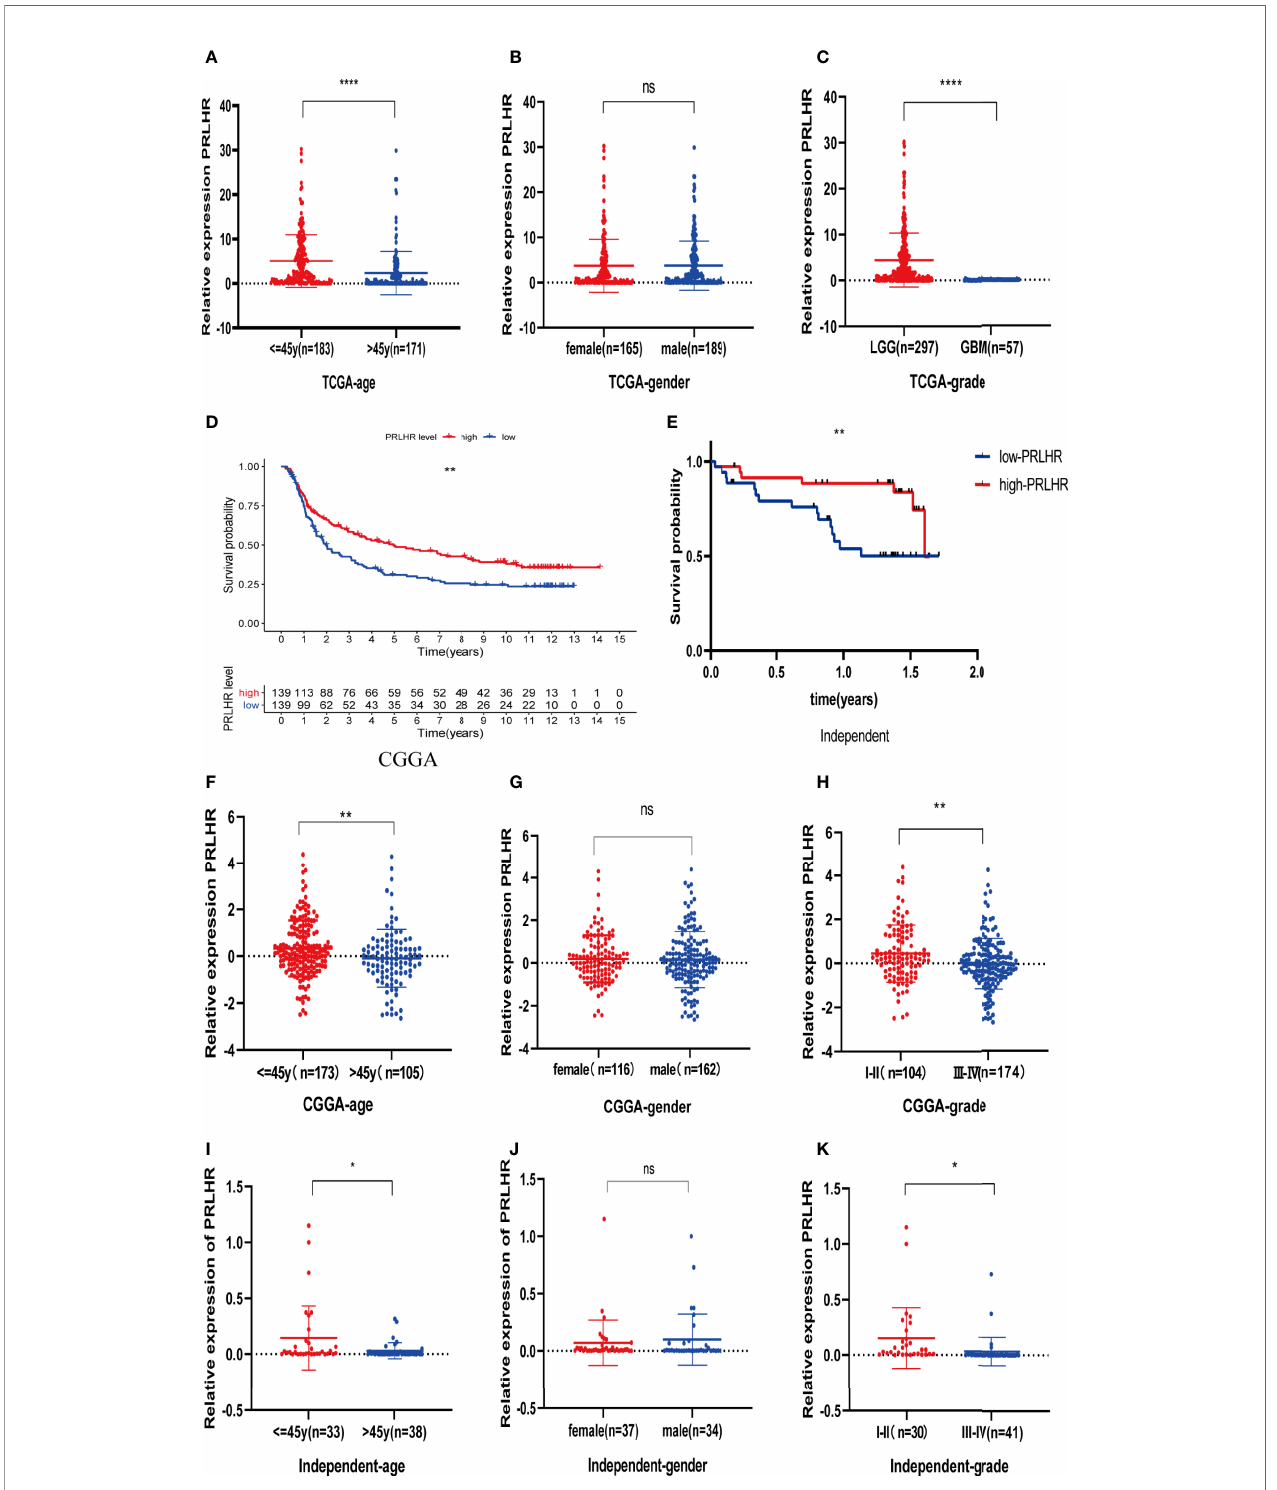
FIGURE 7 | Clinical correlation (age, gender and grade) analysis of PRLHR in TCGA, CGGA, and independent data. (A – C) Analysis of clinical correlation of PRLHR in TCGA (D, E) . PRLHR expression is related to OS of patients with glioma in CGGA and independent data (F – K) . Clinical correlation analysis of PRLHR in CGGA and independent data. *p < 0.05, **p < 0.01, ****p < 0.0001, ns (not signi fi cant) p >